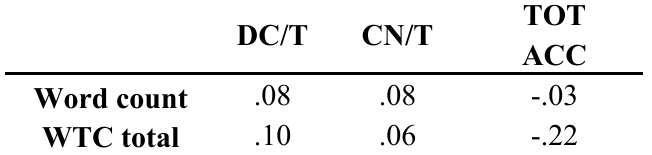
Correlations among Belinda’s topic measures and total complexity and accuracy